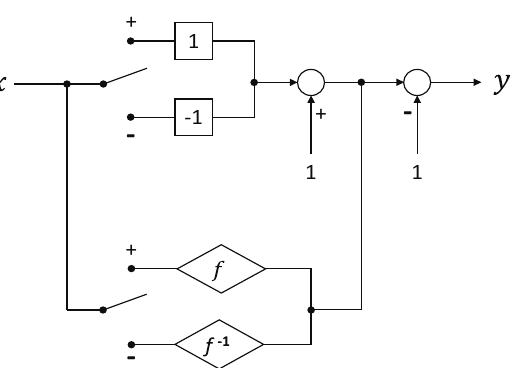
Figure 4. Signal flow diagram of the input passing through the FPLUS activation unit. There are two switches in the diagram, in which the upper one chooses the branch of weight, and the lower one decides to apply negative first power or